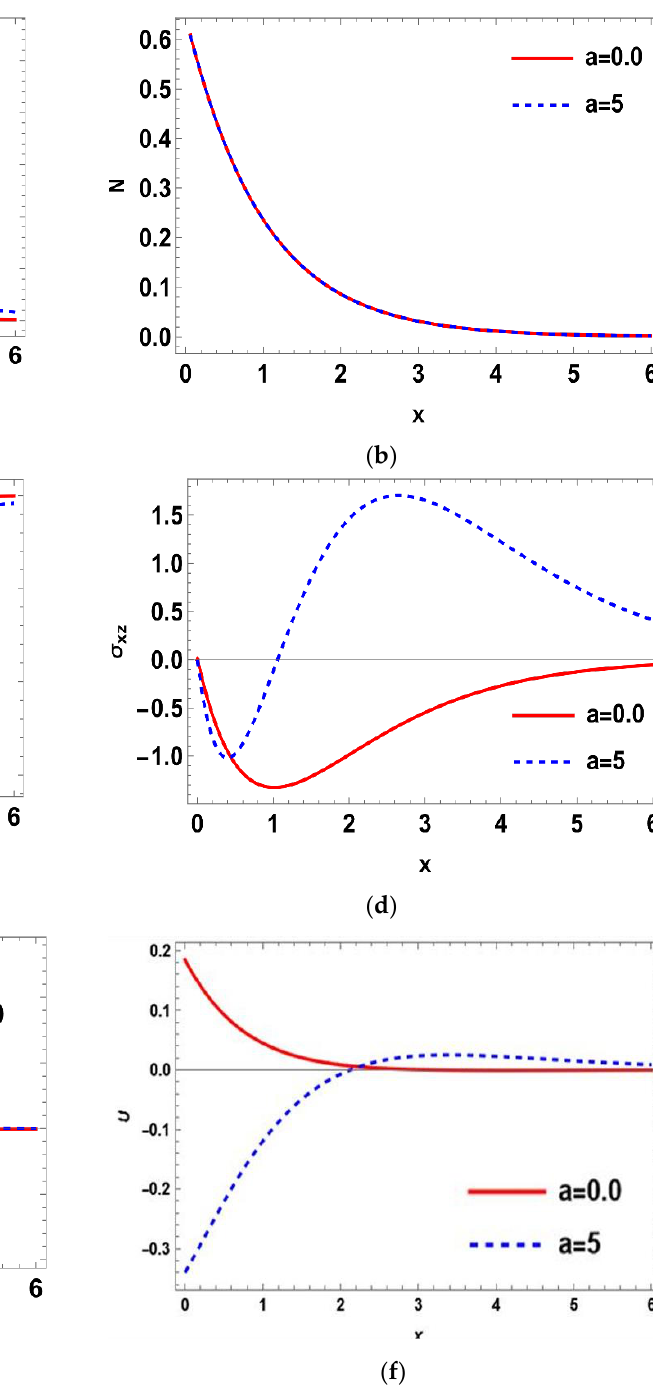
Figure 6. ( a – f ) The variance of temperature, normal stress, carrier density, displacement and heat con- duction distributions around its mean at different values of times 0.2 t = , 0.4 t = and 0.6 t = , when 0 a = .